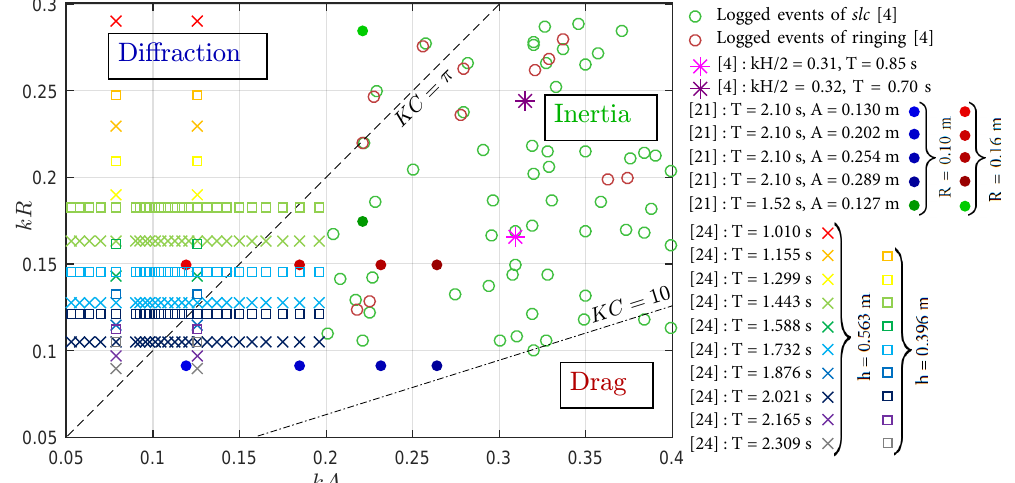
Figure 2. Experimental studies analyzed in this paper, on a ( kA , kR ) -grid, with reference to historically observed secondary load cycles as reported in Grue and Huseby (2002) [4] and the diffraction, inertia and drag regimes separated by the KC number equal to π and 10. Identical markers in the Kristiansen and Faltinsen (2017) [24] cases refer to cases with increasing steepness for the same wave period and water